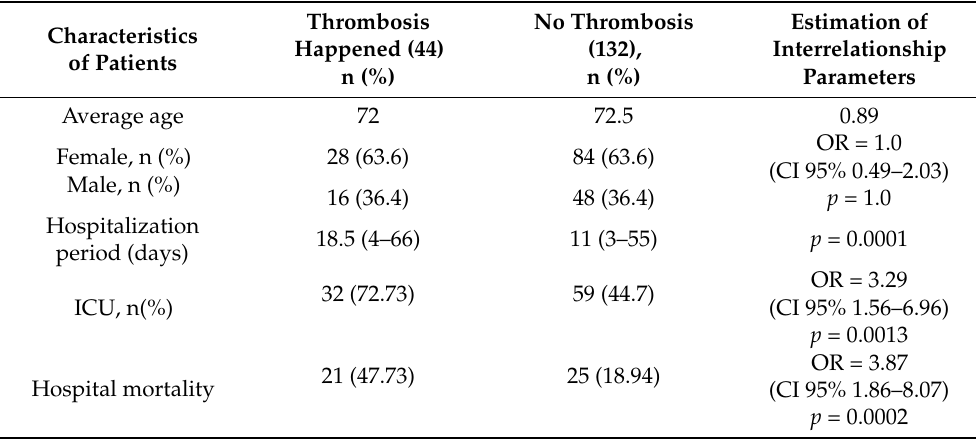
Table 3. Comparative characteristics of patients with and without thrombotic complications and their relation to hospital mortality and ICU